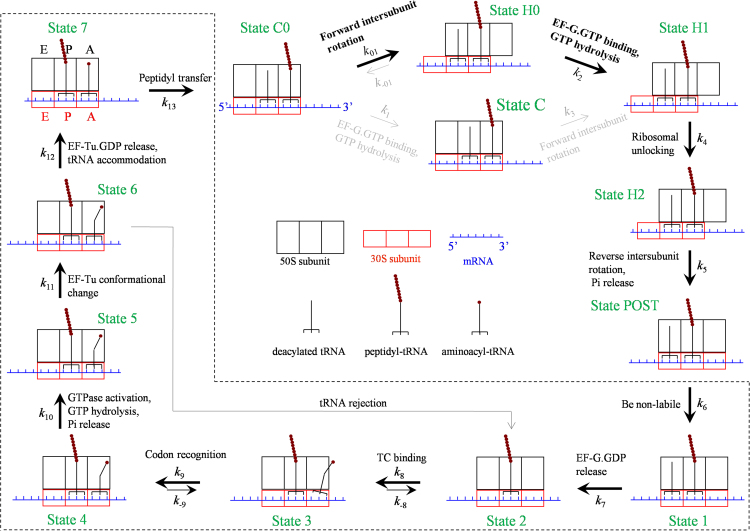
Schematic representation of the elongation pathway for ribosome translation through the single-stranded mRNA (see text for detailed description).